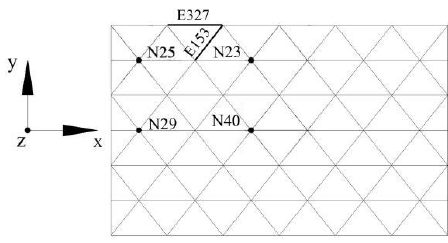
Figure 14. Key nodes and elements of the analytical model. Table 4. Parameters of single-layer cylindrical reticulated shell.